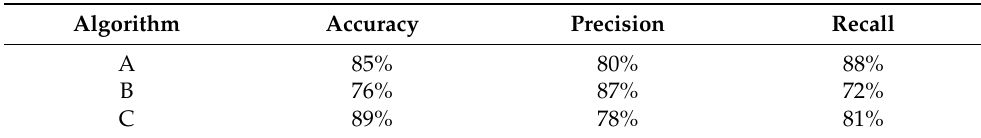
An example of different values of accuracy, precision, and recall for three hypothetical algorithms.